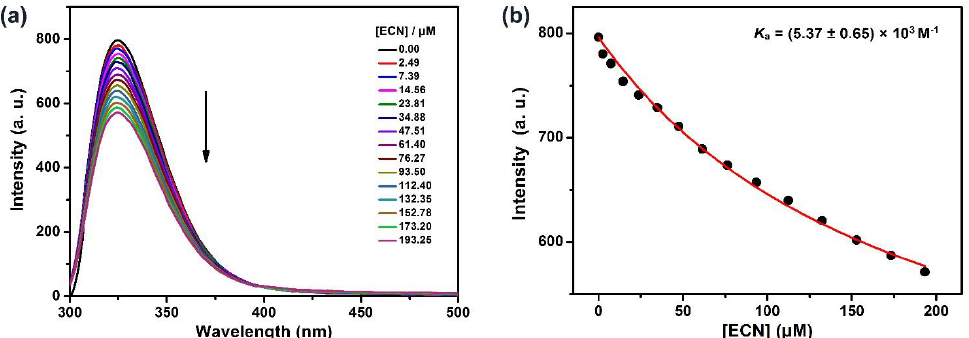
Figure 4. ( a ) Fluorescence titration of TEP6 (1 μM) with ECN in water/methanol (30/70, v / v ), λ ex = 290 nm. ( b ) The associated titration curve at λ em = 325 nm and fit according a 1:1 binding stoichi- ometry.